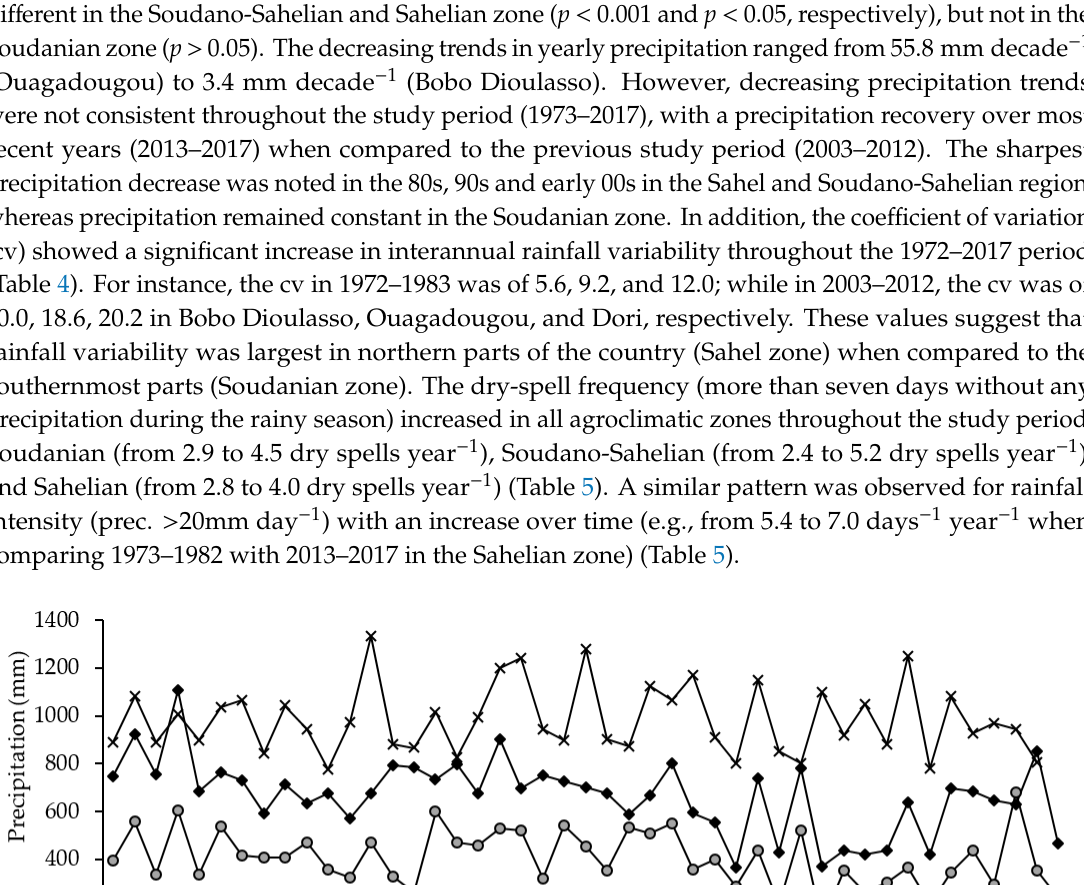
Figure 3. Mean annual minimum temperature (Tmin), lineal regression, and statistical significance along the different agroclimatic zones (Soudanian, Soudano-Sahelian, and Sahelian) for the period